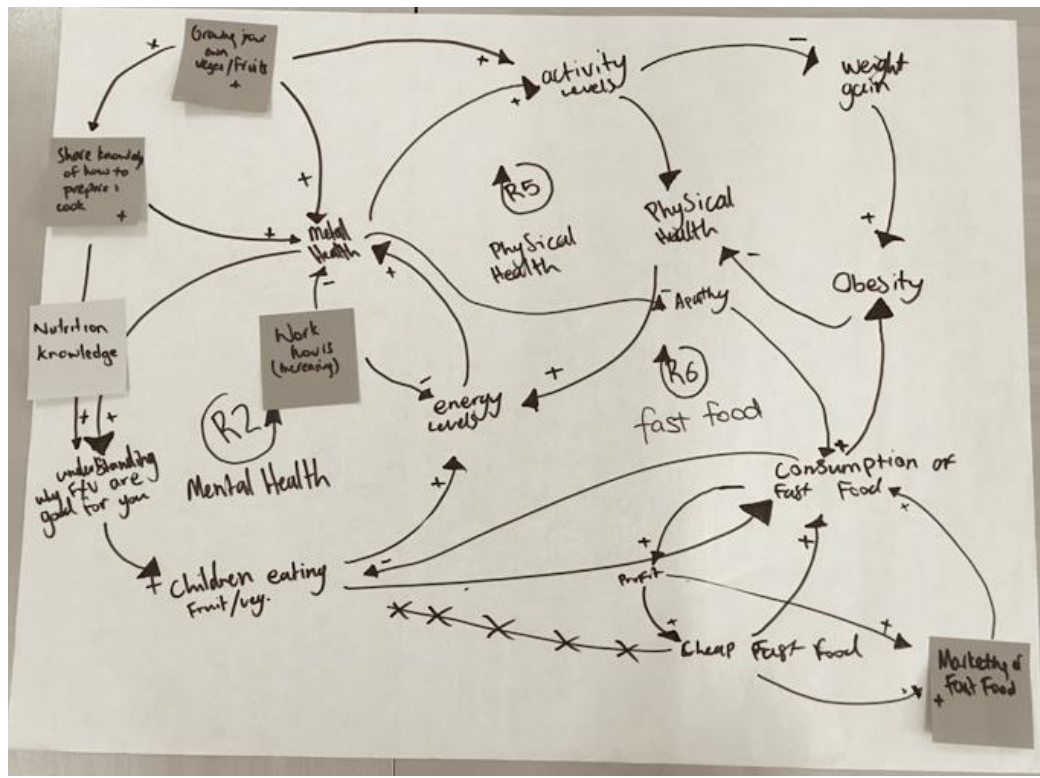
Figure 5. Example of early CLD from one small group.